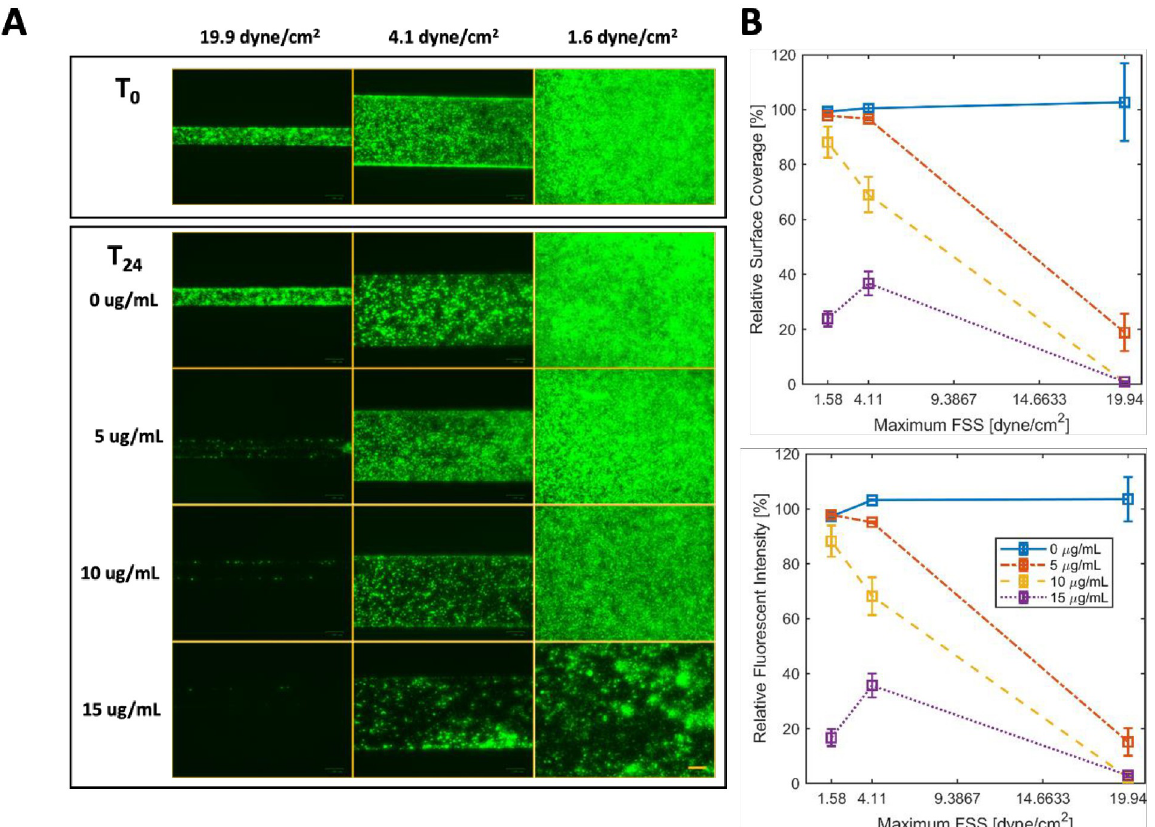
Fig 4. A) Fluorescent images of the on-chip E. coli LF82 biofilms and the physicochemical effects of increasing concentration of gentamicin and fluid shear stress after 24 h treatment. B) Relative changes in surface coverage and total fluorescent intensity of E. coli biofilms after 24 h treatment under different concentrations of gentamicin and levels of fluid shear stress were evaluated by MatLab analysis of fluorescent images. Data represent the mean of three replicates, reported as the percentage normalized with the initial time point (T 0 ) of each treatment. Values are expressed as means ± SEM, n = 3. Scale bar = 100 μ